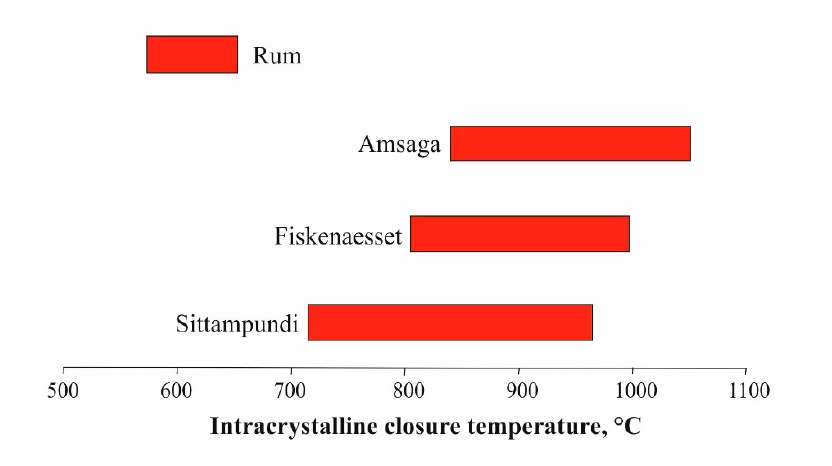
Figure 5. Range of intracrystalline closure temperatures (°C) for the spinel composition investigated and other occurrences of Cr ‐ spinels from chromitites in anorthosites used for comparison (Fiskenæsset, unpublished data; Amsaga [34]; Rum [32]).